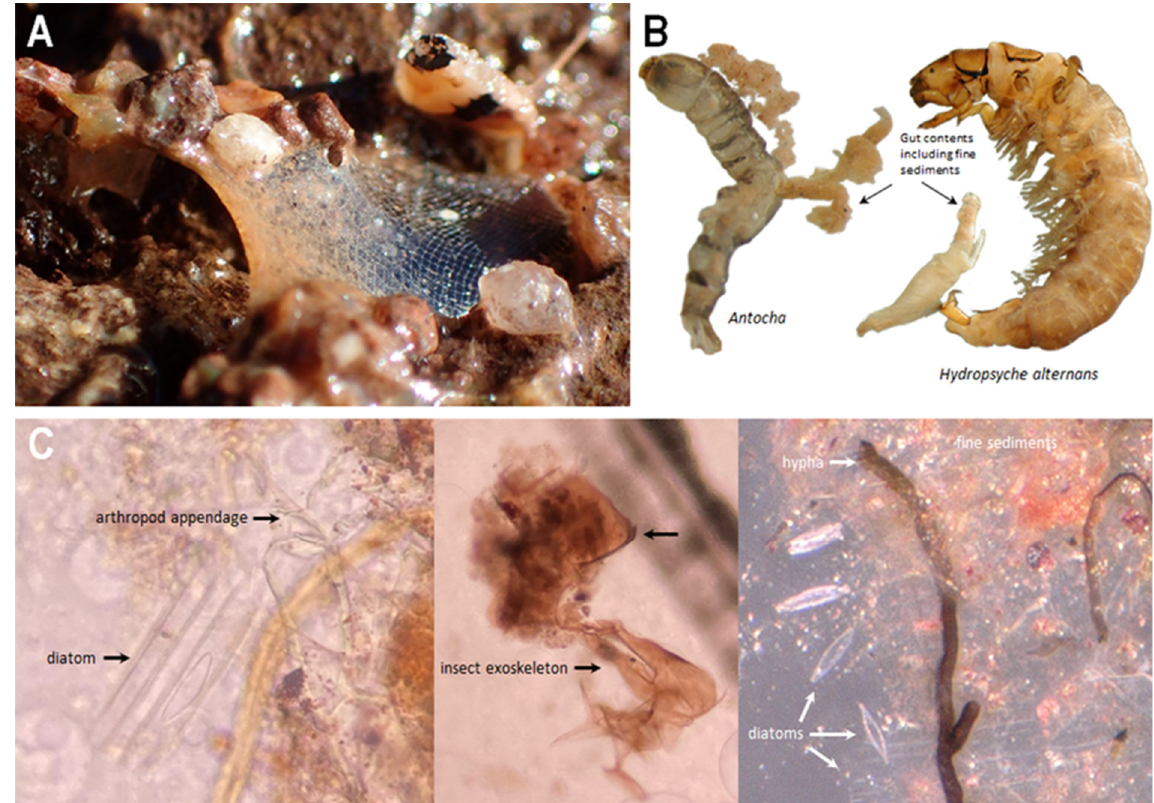
Figure 8. Hydropsyche alternans feeding and diet, ( A ) silken net filled with fine particles; ( B ) bodies and partially removed gut contents of Antocha (Diptera: Limoniidae) and H. alternans showing fine sediment in guts; ( C ) micrographs of H. alternans gut content items.